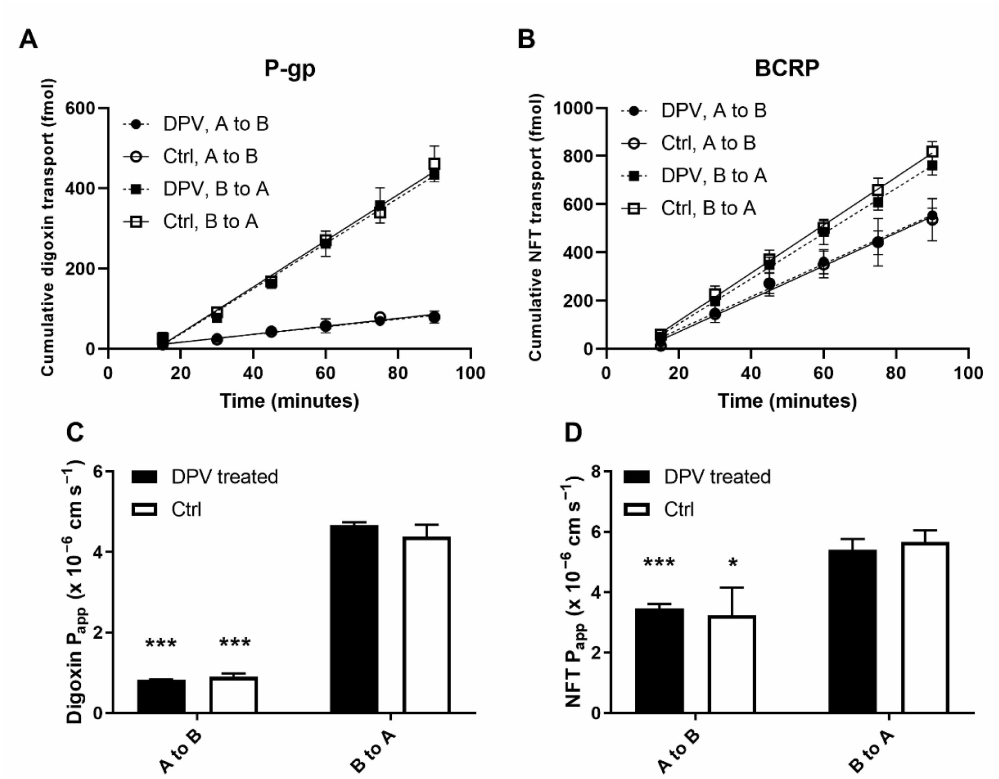
Figure 4. Bi-directional transport of digoxin across MDCKII P-gp ( A ) and nitrofurantoin (NFT) across MDCKII BCRP ( B ) cell monolayers with and without DPV (DPV and Ctrl); P app values obtained from the transport assays ( C , D ). Data represented as mean ± SD of three biological replicates. * p < 0.05 in comparison to B to A. *** p < 0.001 in comparison to B to A (Student’s t